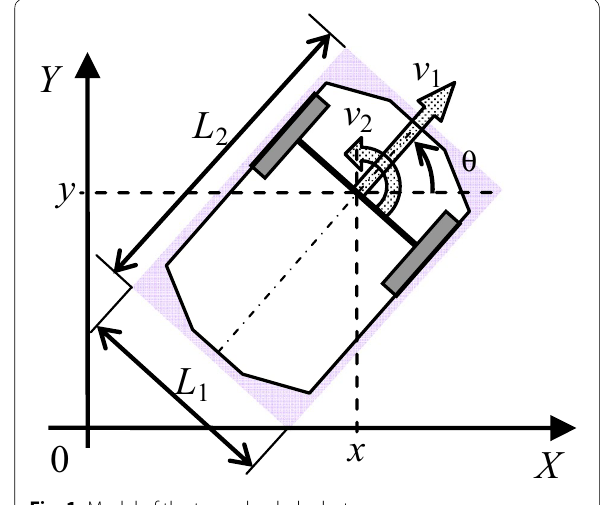
Fig. 1 Model of the two-wheeled